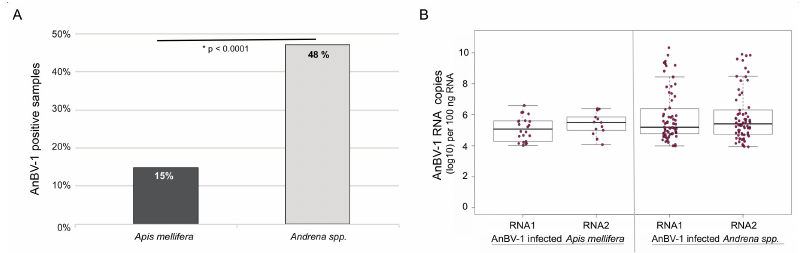
Figure 4. Andrena-associated bee virus-1 (AnBV-1) is more prevalent in Andrena. ( A ). AnBV-1 prevalence in this sample cohort, which represents a single sampling date at each of 14 sites, was determined from binary analysis of quantitative PCR (i.e., a sample was designated either positive (1) or negative (0) for AnBV-1) and presented as the percent AnBV-1 positive samples for each species. Specifically, 22 of the 143 Apis mellifera samples analyzed were AnBV-1 positive (15%) and 71 of the 148 Andrena spp. samples analyzed were AnBV-1 positive (48%). The data were analyzed using a chi square test for proportions, where X 2 = 44.057, df = 1, and * p -value = 3 × 10 − 11 . ( B ). Quantitative PCR was used to determine the AnBV-1 RNA 1 or RNA 2 copy number in individual AnBV-1-positive Apis mellifera and Andrena spp . samples. Samples with undetectable AnBV-1 levels were not graphed or analyzed. Comparison of the RNA abundance between species using Dunnett’s test indicates that AnBV-1 RNA 1 abundance was greater in Andrena spp. samples compared to Apis mellifera samples ( p = 0.0279), but RNA 2 abundance between the two species was not significant, p =